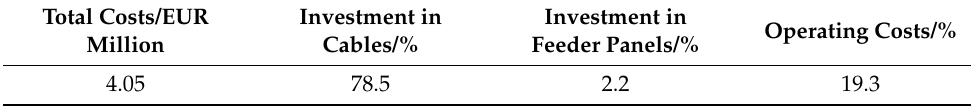
Table 13. Results of the planning variant with underground cables.